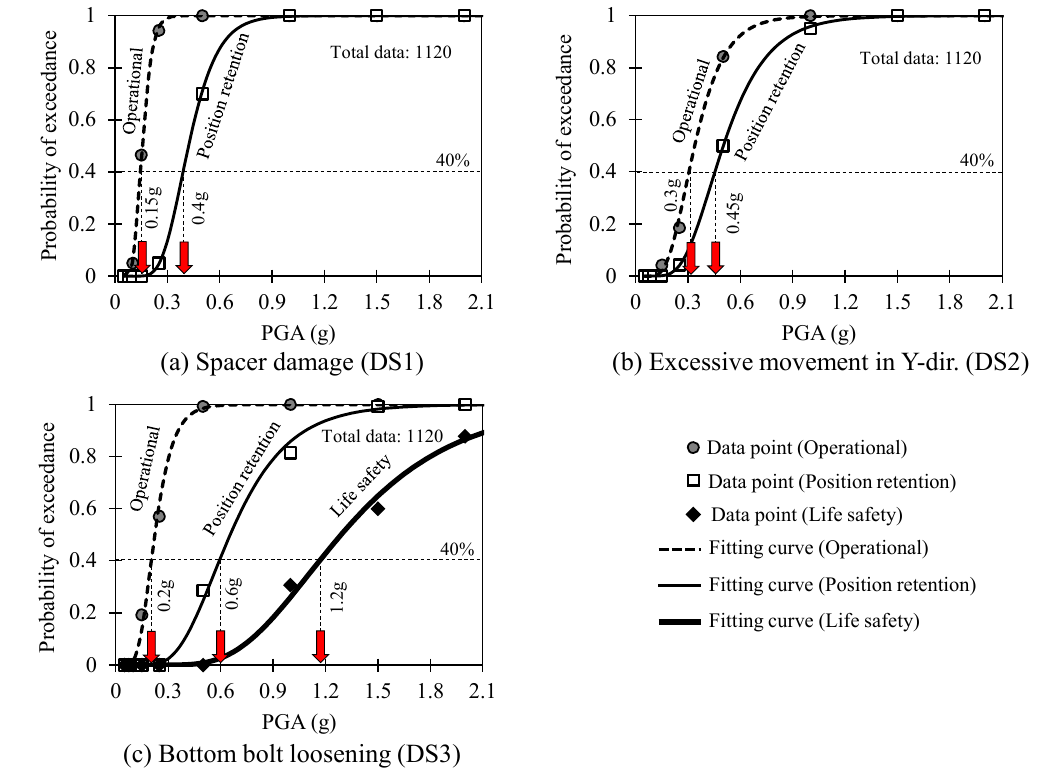
Figure 24. Fragility curves for different damage states of the mold transformer.